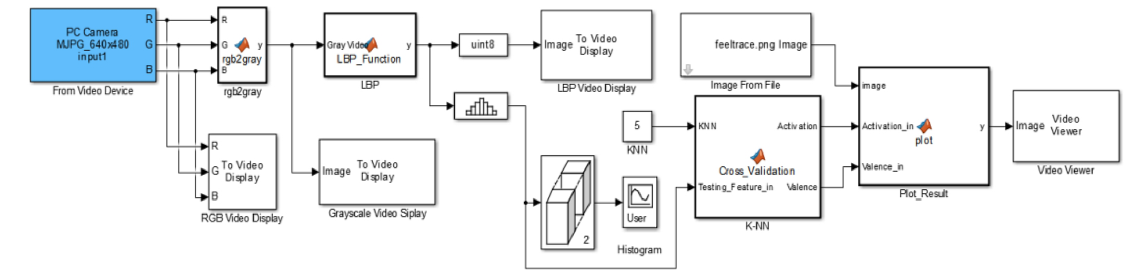
Figure 5. Simulink data workflow diagram.